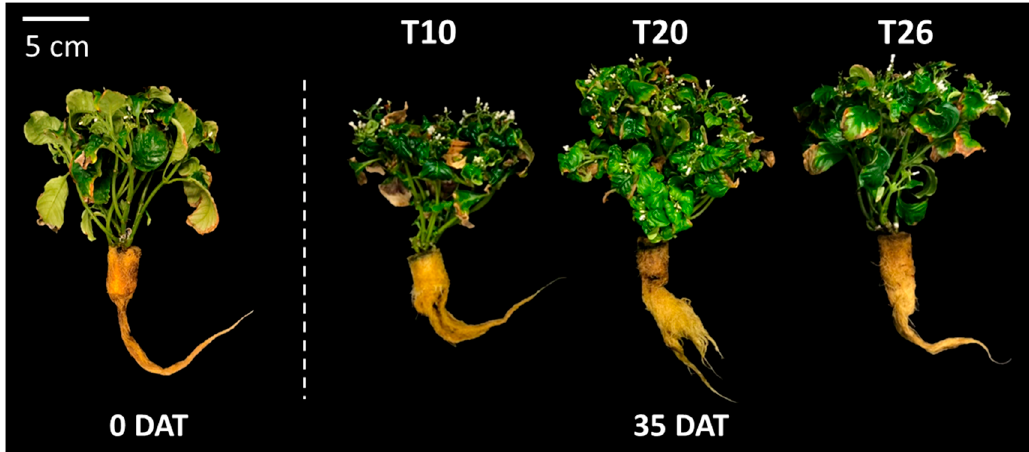
Figure 6. Pictures of O. pumila treated at each nutrient solution temperature (NST) at 0 and 35 days after the start of the treatment (DAT) in experiment 2. The NST treatments were set at 10, 20, and 26 °C as T10, T20, and T26, respectively. The NSTs at T10 and T20 were maintained using a handy cooler, and that at T26 was not controlled.